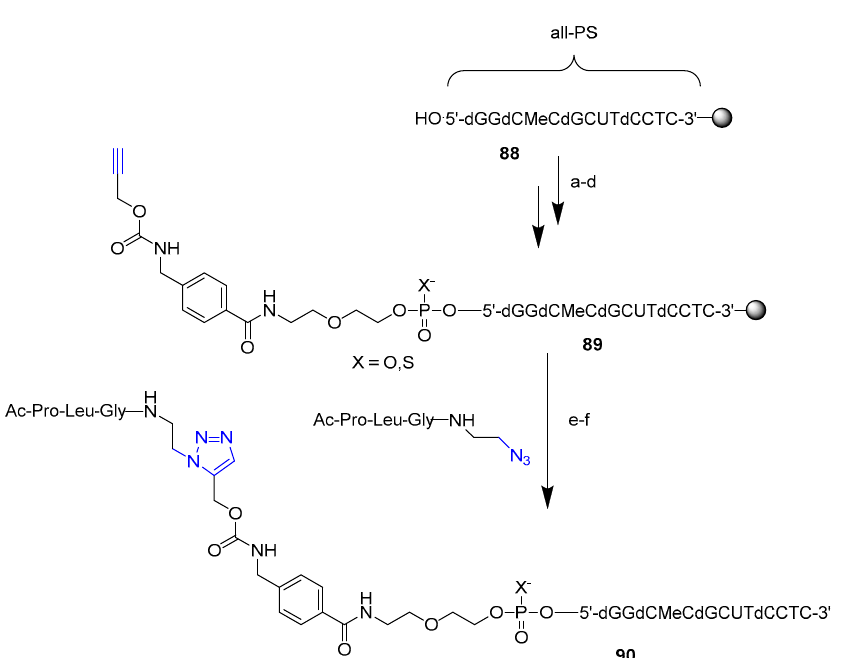
Scheme 22. Solid-phase synthesis of 5 ′ alkyne modified oligonucleotide and CuAAC reaction: ( a ) alkynyl linker, PvCl, MeCN/Py (3:1), 5 min, r.t.; ( b ) I 2 /Py/H 2 O, 15 min, r.t. or S 8 , Et 3 N, BSA, r.t.